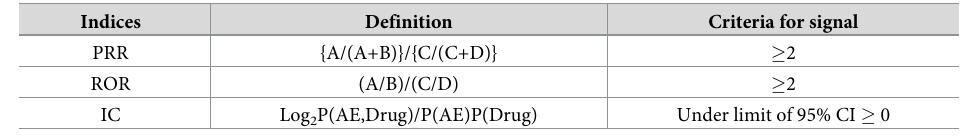
Table 2. Formula and signal detection